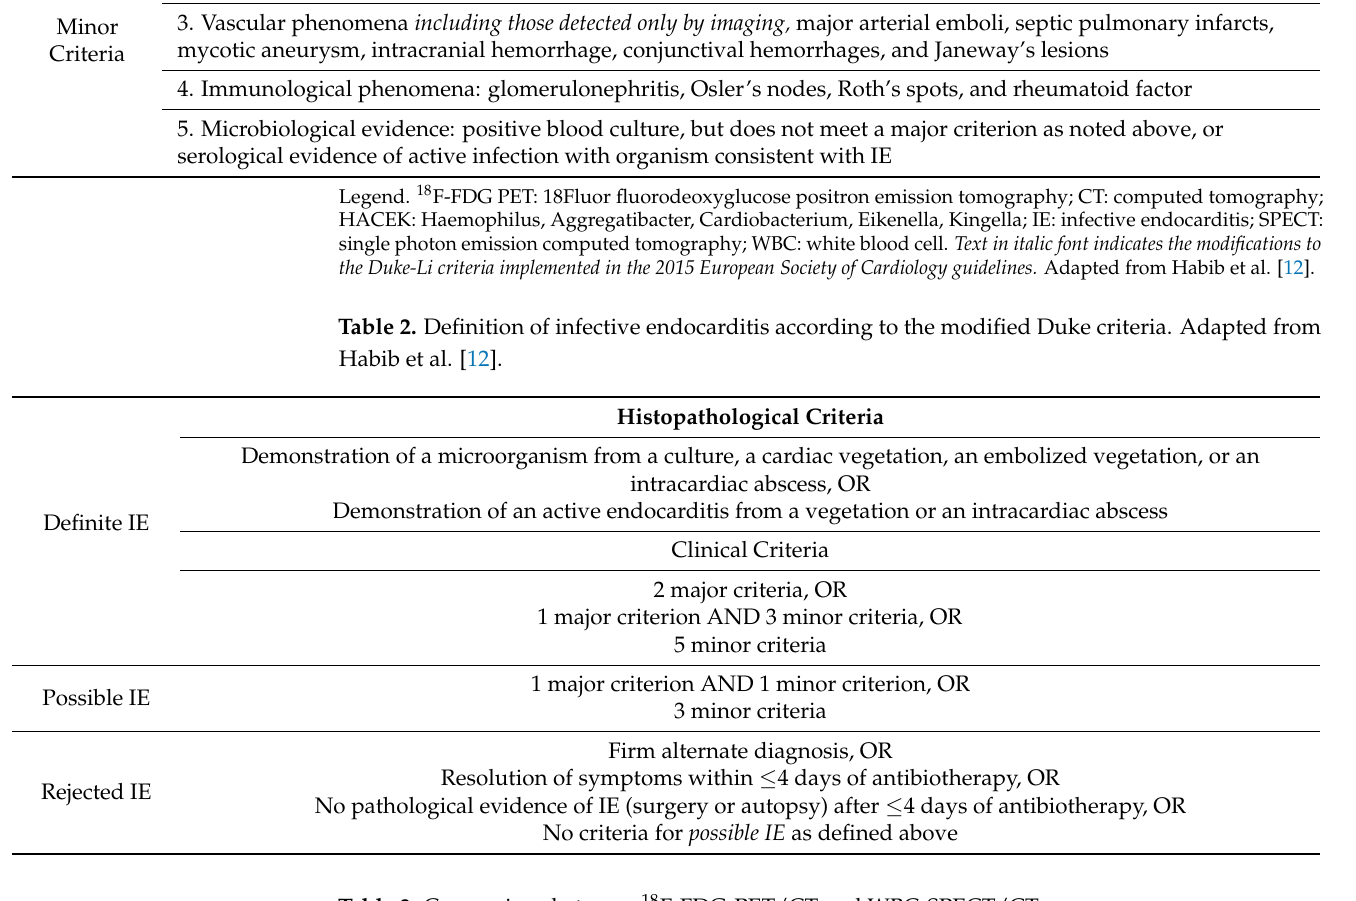
Table 3. Comparison between 18 F-FDG-PET/CT and